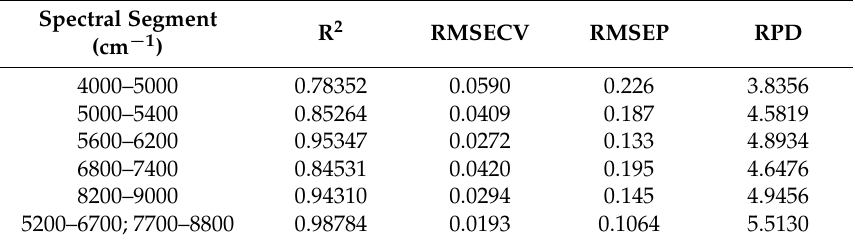
Table 4. The influence of different spectral wavenumbers on the quantitative model.